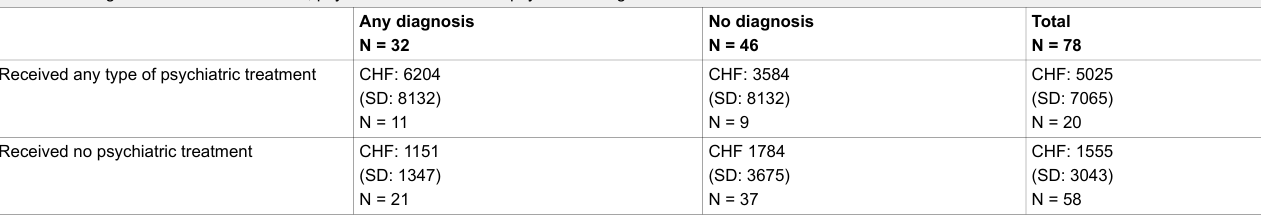
Table 6: Average annual healthcare costs, psychiatric treatment and psychiatric diagnosis.